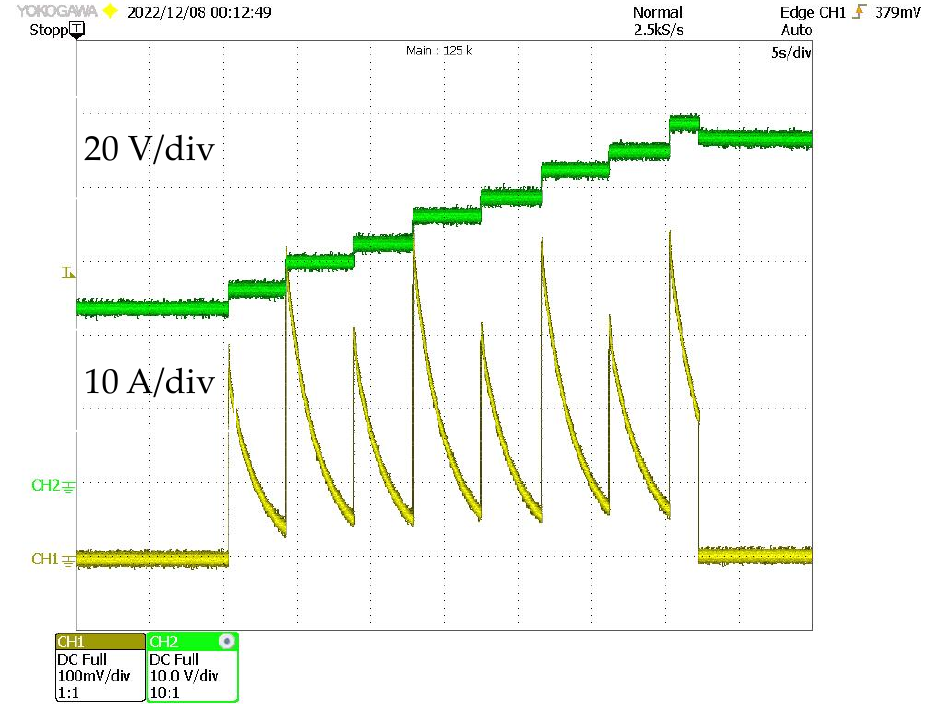
Figure 44. Experimentally obtained diagrams of charging current and voltage.